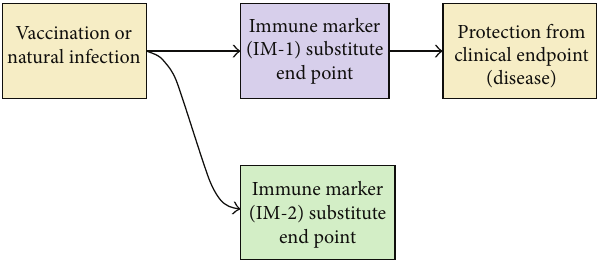
Figure 2: Process of immunity and correlates of protection. Immune markers 1 and 2 (IM-1, IM-2) are correlates of protection, but only IM-1 is a surrogate. Arrows imply direct causal relation- ships. Figure adapted from WHO